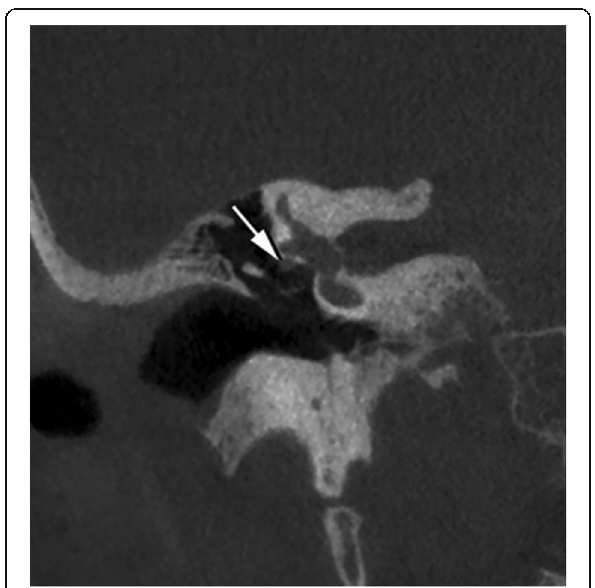
Fig. 7 Facial nerve canal dehiscence. Coronal CBCT reconstruction shows dehiscence of the canal and minimal protrusion of the facial nerve (arrow) within the middle ear